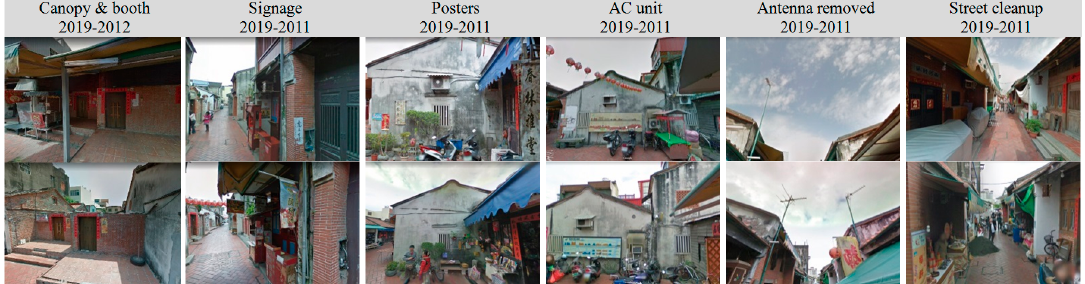
Figure 5. Objects added to the second skin between 2019 ( top ) and 2011 (or 2012) ( bottom ).